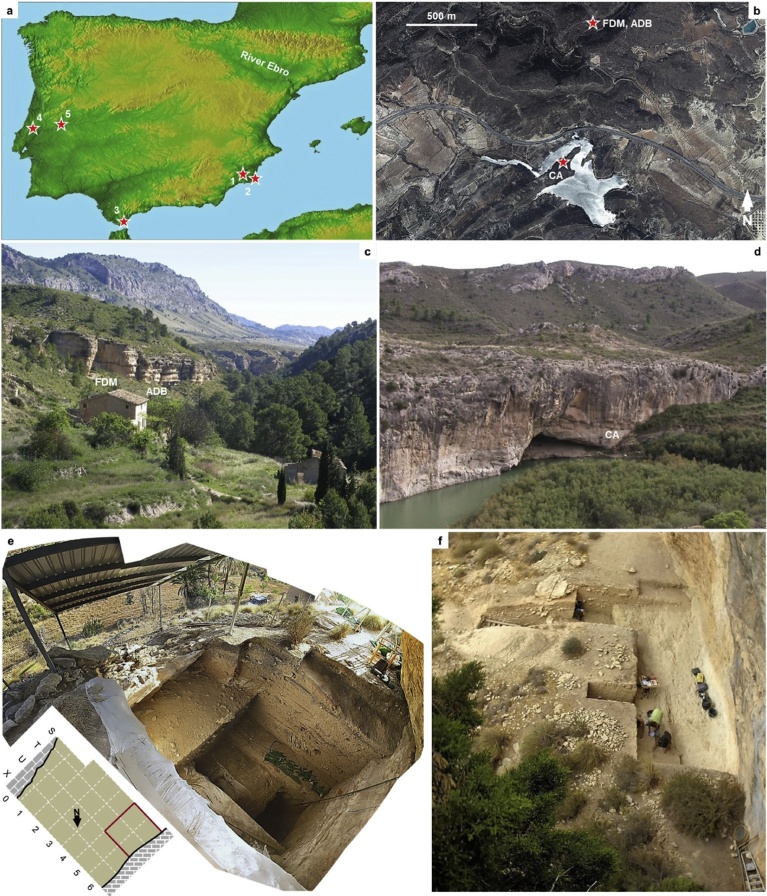
The Mula basin sites. a. Location of the late Middle Paleolithic sites of Southern and Western Iberia relative to the Ebro basin (1. Cueva Antón; 2. Sima de las Palomas; 3. Gorham’s Cave; 4. Gruta da Oliveira; 5. Foz do Enxarrique). b. Location of the Mula basin sites in a 2013 orthophoto.